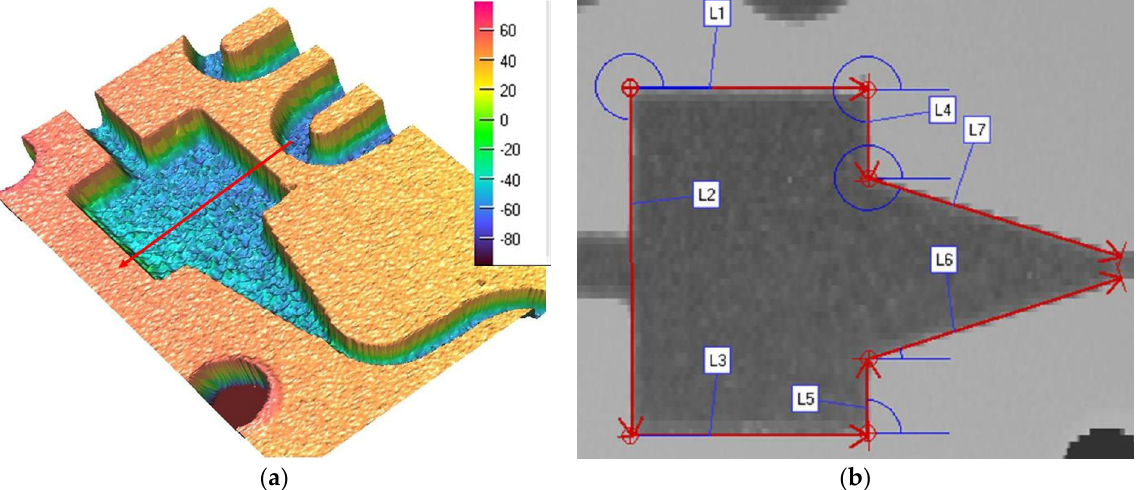
Figure 8. Convergent lamination nozzle area: ( a ) 3D representation, ( b ) measured regions. Table 2. Dimensions of the convergent nozzle.